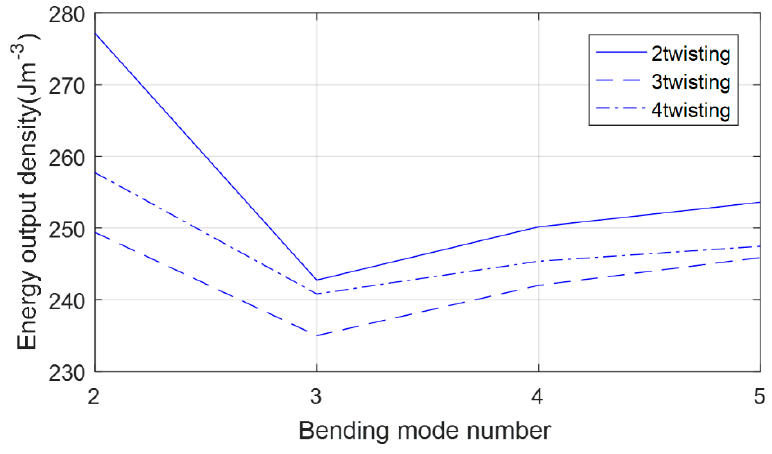
Figure 3. Energy output with bending-twisting modes in the Rayleigh-Ritz method.